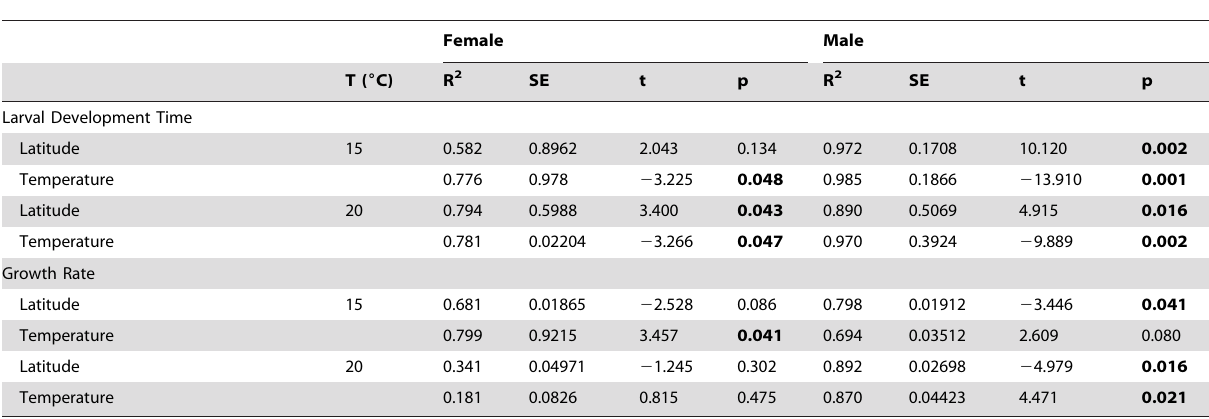
Table 3. Latitudinal patterns in growth and development.